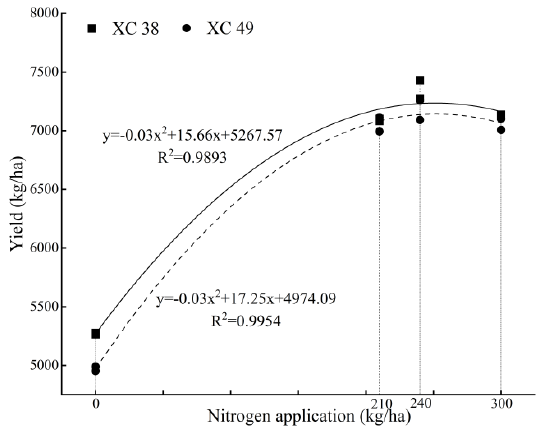
Figure 7. Nitrogen fertilizer yield effect curve.